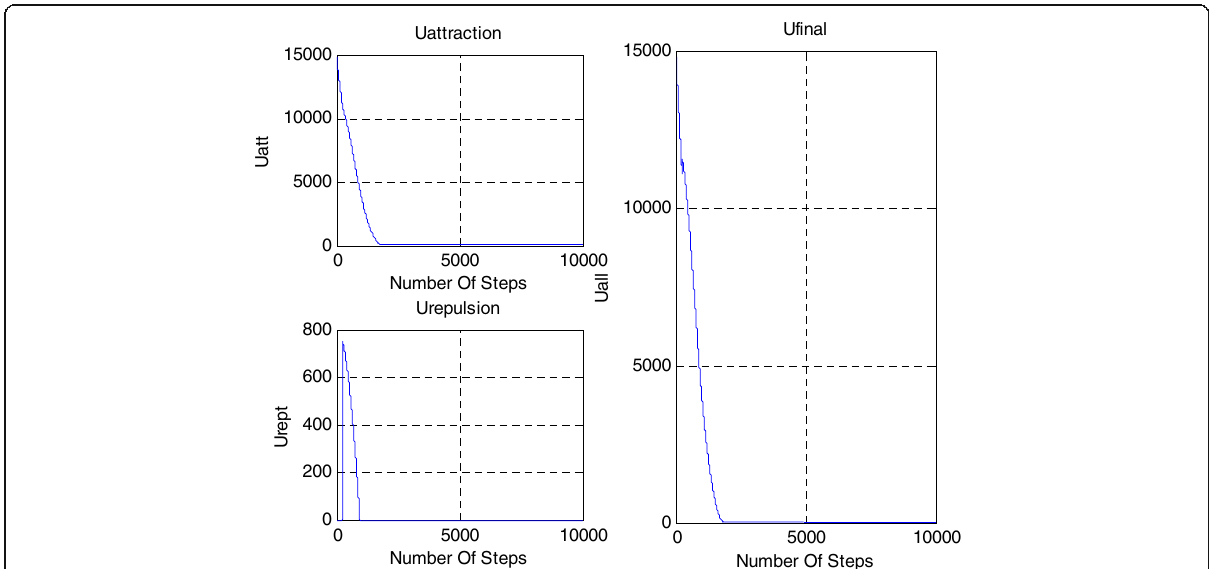
Fig. 15 The energy amount of repulsion and attraction and their yields according to the number of steps in the modified artificial potential field algorithm for circular obstacle with radius R = 30